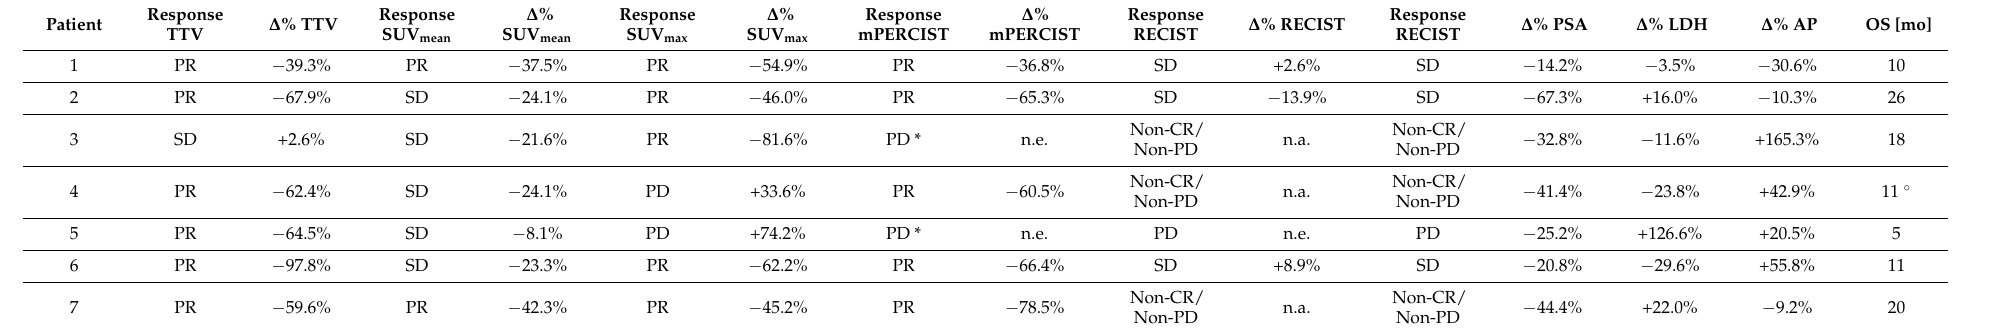
Table 6. Comparison of different response classifiers among patients undergoing ≥ 2 cycles and with follow-up 18 F-PSMA-1007 PET/CT after the second